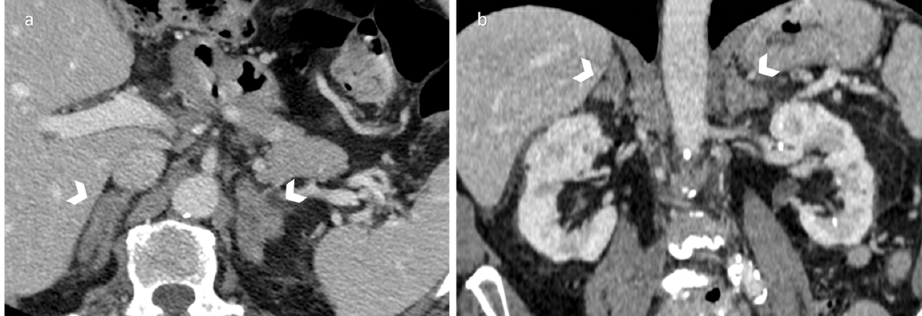
Figure 3. Axial unenhanced CT ( a ) and coronal reformatted portal venous phase of contrast-enhanced CT ( b ) of a 65-year-old man with bilateral adrenal hyperplasia. Note the symmetrical bilateral thickening of adrenal glands, presenting normal contours and no mass lesions.